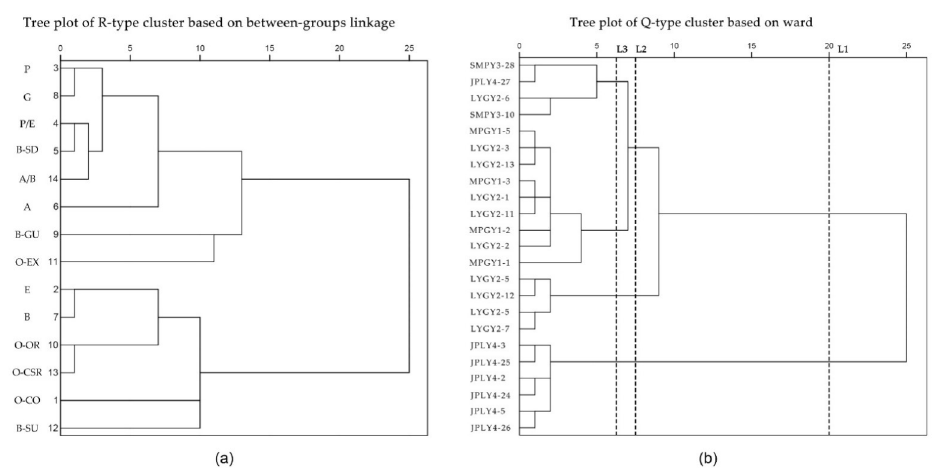
Figure 4. Heatmaps for Pearson’s linear correlation coefficients between observed quantitative and qualitative traits (Table 1) of C. argyrophylla . The heatmap shows the magnitude of a phenomenon as color in two dimensions: a positive or negative number, respectively, denotes a positive or negative correlation between row and column traits (P, length of polar axis; E, equatorial diameter; A, length of saccus; B, width of saccus; G, length of germinal anacolpus; and the A/B and P/E ratios; B-SD, whether the outline of two sacci was distinct or not in polar proximal view; B-GU, whether the width of the germinal anacolpus was uniformed or not in polar distal view; B-SU, whether the overall size of two sacci was uniformed or not; O-OR, overall roughness of pollen; O-CSR, the roughness degree between corpus from the polar proximal view and the sacci from the polar distal view; O-CO, the pollen corpus outlined in the polar distal view; O-EX, ornament of exine surface). * p < 0.05, ** p < 0.01.